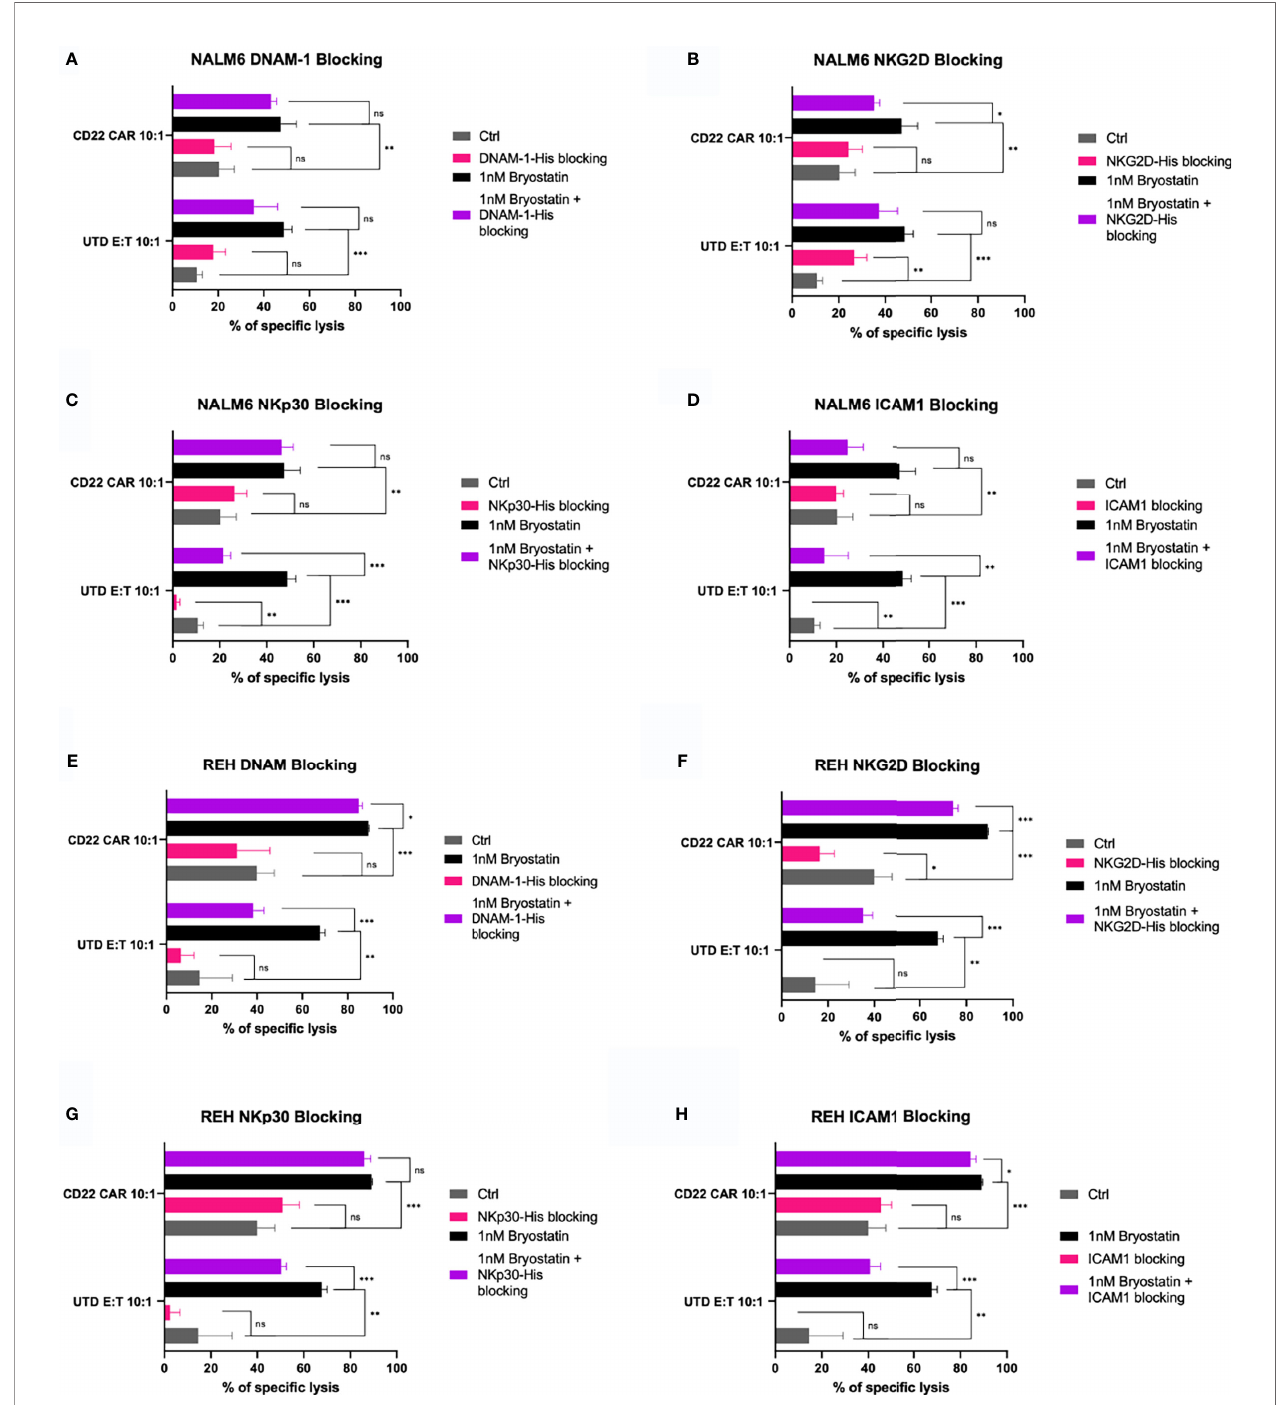
FIGURE 11 | Blocking of innate immunoreceptor ligands during CAR-T mediated cytolysis. The NALM6 pre-B ALL cell line was exposed to anti-CD22 CAR-T or control UTD cells at an E:T ratio of 10:1, y-axis. Results are grouped in each panel by cytolysis seen with untreated target (gray, control), bryostatin treatment (black), or treated with blocking agent (pink) or blocking agent and bryostatin (purple), using (A) recombinant DNAM-1, (B) NKG2D, (C) NKp30, or (D) anti-ICAM1 antibody, for 30 minutes prior to addition of effector cells. Average of 3 replicate wells are shown, with statistical difference between groups plotted, ns p > 0.05, *p < 0.05, **p < 0.01, ***p < 0.001. (E – H) REH leukemia cells were similarly